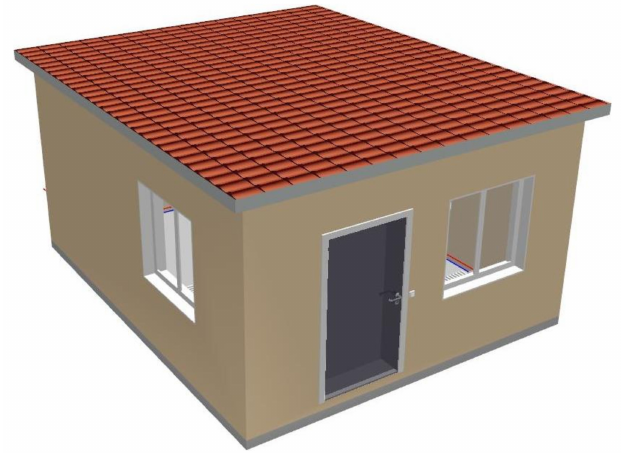
Figure 2. Graphical representation of the single freestanding room (Supplementary